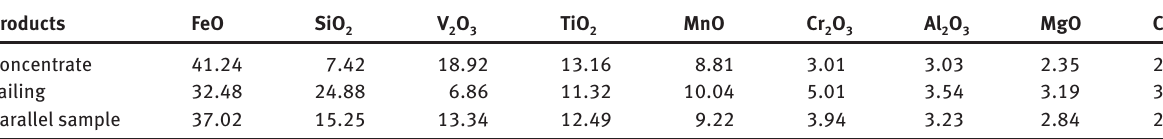
Table 5: XRF result of nine composition of the concentrating products (mass fraction, %) Products FeO Concentrate Tailing Parallel sample